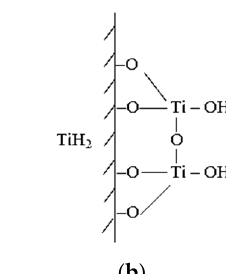
Figure 9. Mechanism of interaction of titanium sulfuric acid salts with the shot surface.